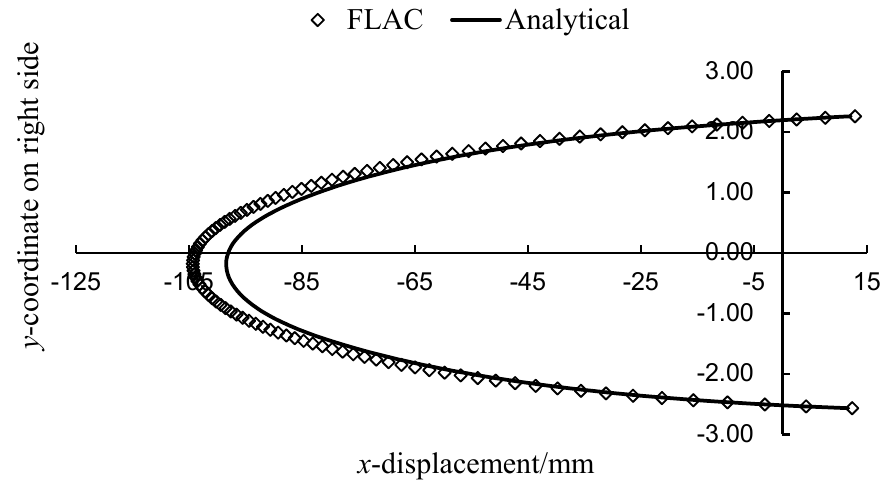
Figure 8. The x -displacement on t he right side for right-angle trapezoidal opening.